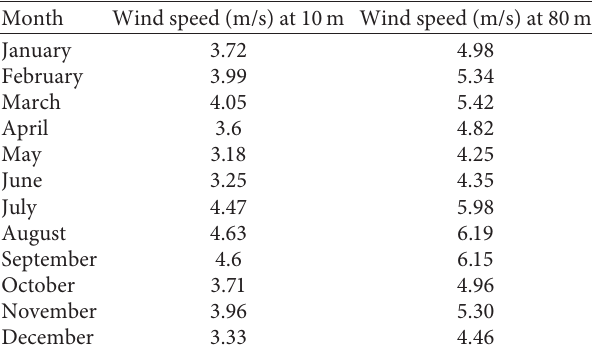
Table 3: Wind resource assessment of